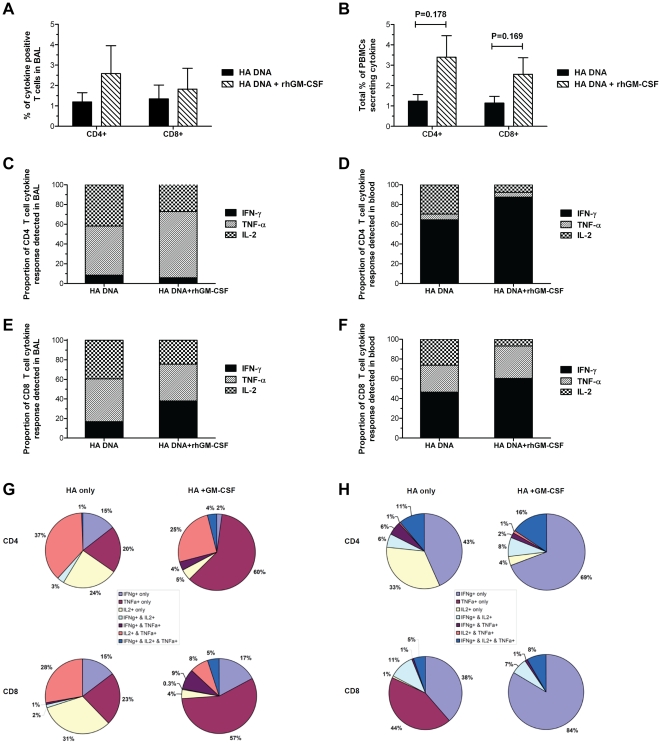
Generation of multifunctional T cells in the peripheral blood and lungs of macaques following PMED HA DNA vaccination.Intracellular cytokine staining was performed on BALF collected from both vaccine groups at 4 weeks after the first boost (panels on left), as well as PBMCs from both vaccine groups collected 4 weeks after the second boost (panels on right) to measure the expression of IFN-γ, TNF-α, and IL-2 by CD4+ and CD8+ T cells after stimulation with overlapping peptides derived from the A/New Caledonia/20/99 HA protein. Bar charts show the mean total percentage (+/− SEM) of CD4+ and CD8+ T cells in the lungs (A) and blood (B) of animals from the unadjuvanted (black bars) and GM-CSF adjuvanted (hatched bars) found to express IFN-γ, TNF-α, or IL-2 following HA peptide stimulation. Indicated P values were determined using the Mann-Whitney U test (two-tailed). Stacked bar charts show the mean proportion of cells producing IFN-γ (black), TNF-α (gray), or IL-2 (hatched) to the total HA-specific CD4+ and CD8+ T cell response detected in the lung (C, E) and blood (D, F) of animals from the unadjuvanted and GM-CSF adjuvanted vaccine groups. Pie charts show the proportion of HA-specific CD4+ and CD8+ T cells in the lung (G) and blood (H) from both vaccine groups positive for the different combinations of one, two, or three cytokines.